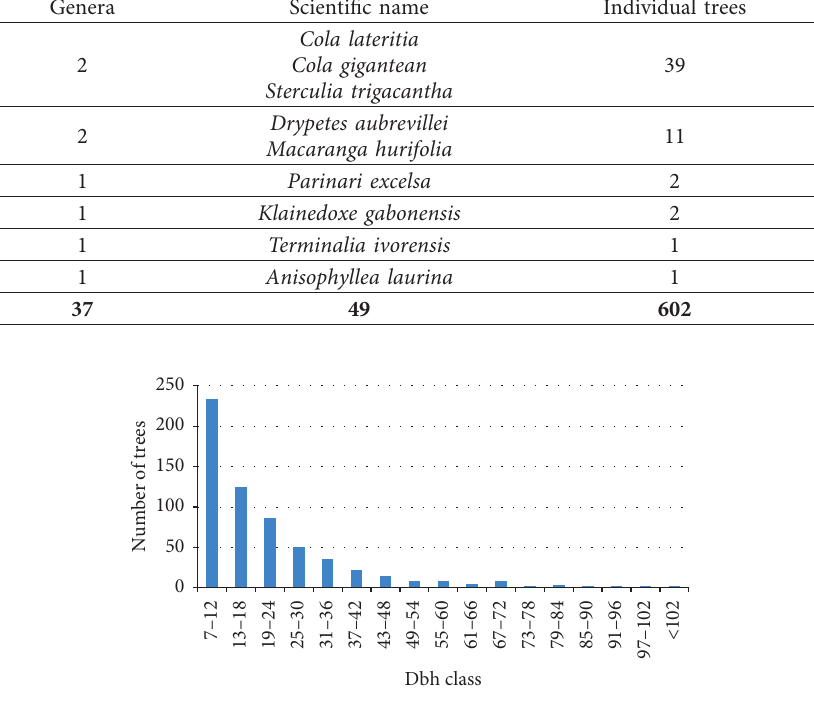
Figure 1: Dbh class distribution of